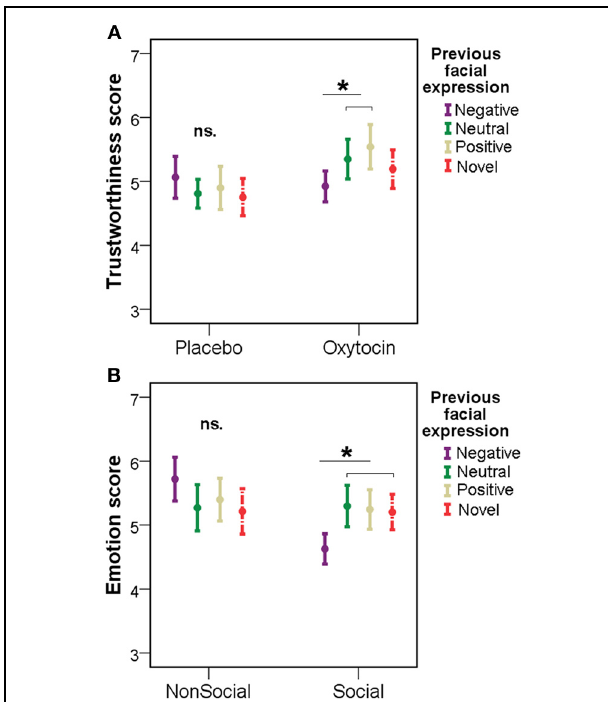
FIGURE 4 | Trustworthiness scores (mean ± SE) for faces that had previously been shown with positive/negative/neutral emotional expressions in the PL/OT (A) and NSoc/Soc (B) groups. ∗ p < 0 .